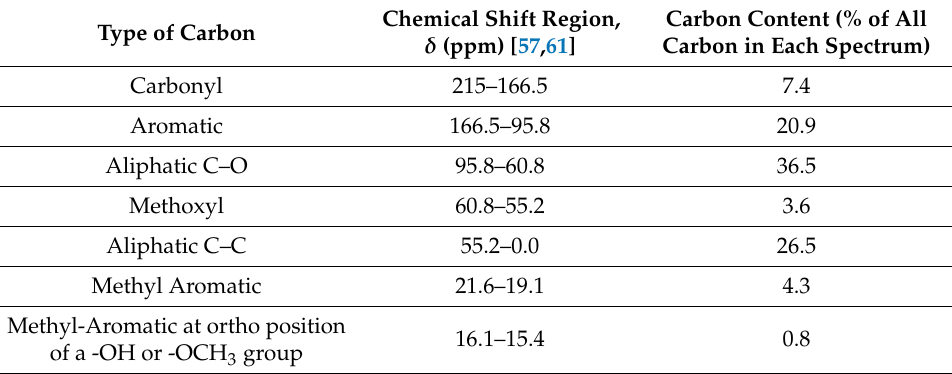
Figure 7. 13 C-NMR spectrum of bio-oil obtained from pigeon pea wood pyrolysis at optimized conditions, showing several peaks belonging to different functional groups as indicated. Table 6. 13 C-NMR integrations for specific chemical shift regions for bio-oil from pigeon pea wood pyrolysis at optimized conditions.